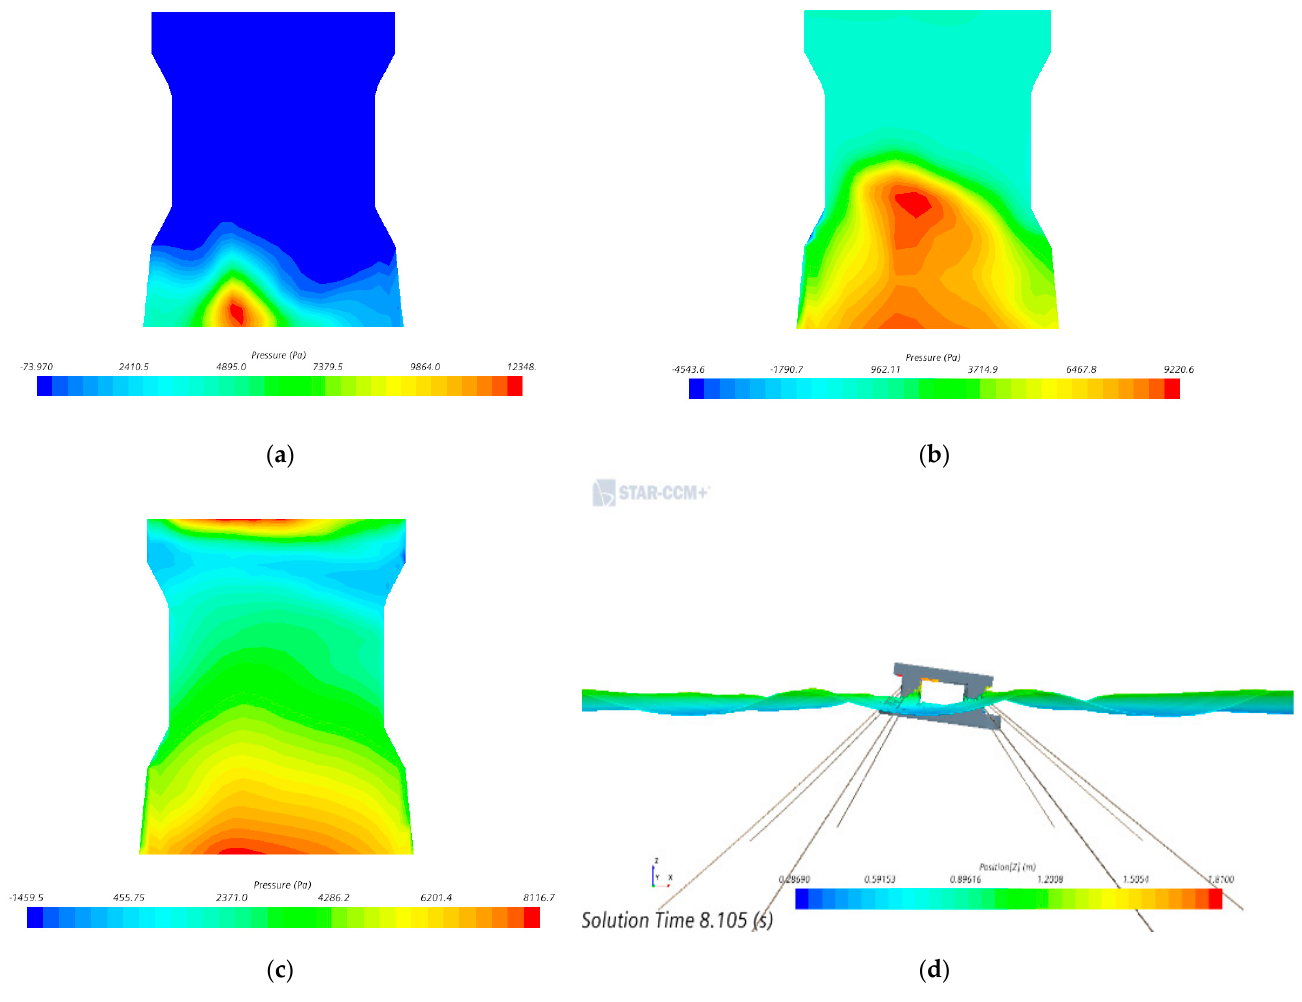
Figure 17. ( a – c ) Distribution of slamming pressure on the surface of the column during a wave period. ( d ) Side view of the platform moving in the waves.